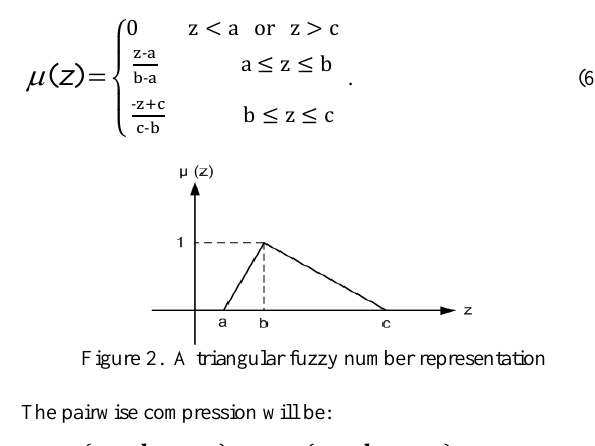
Table 1. Guidelines for determining users’ bother Mode